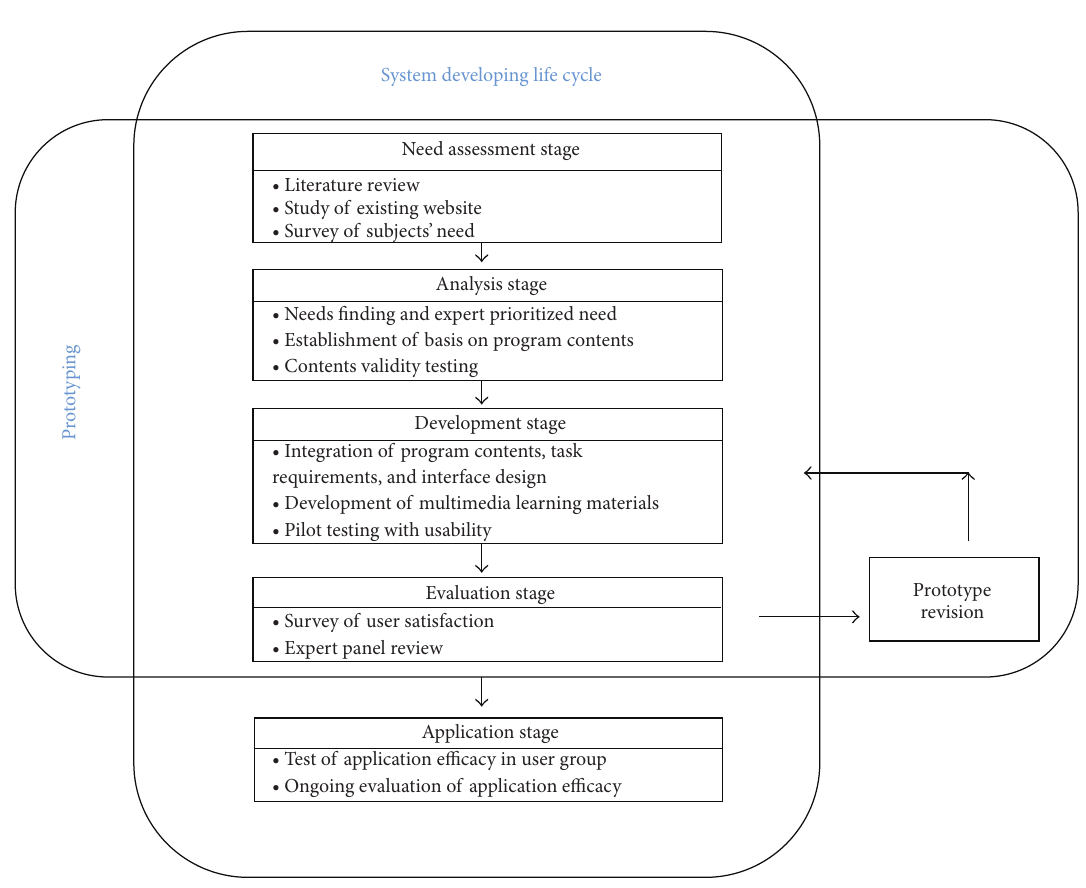
F 1: Stages for the development of an online program for promoting